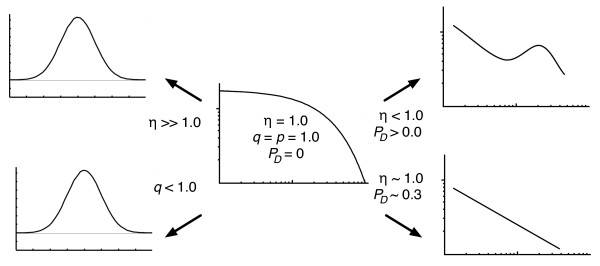
Changing a network's degree distribution. This sketch indicates how different degree distributions morph into one another as several different parameters of the growth model are changed. From the "default" exponential degree distribution of the Callaway model (center of diagram) Erdös-Rényi-like distributions can be obtained in two different ways: either by increasing the probability to add edges while keeping the node addition probability constant, or by randomizing edges using a small q (distributions on the left, note the non-logarithmic axes). Approximately scale-free distributions can be obtained from the exponential one by increasing the node duplication probability, but doing so while decreasing the number of edges per node creates a hybrid between scale-free and Erdös-Rényi-type distributions (distributions on the right).